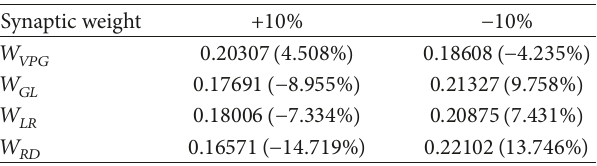
Table 3: Baseline activity of DA neurons given increased or decreased synaptic